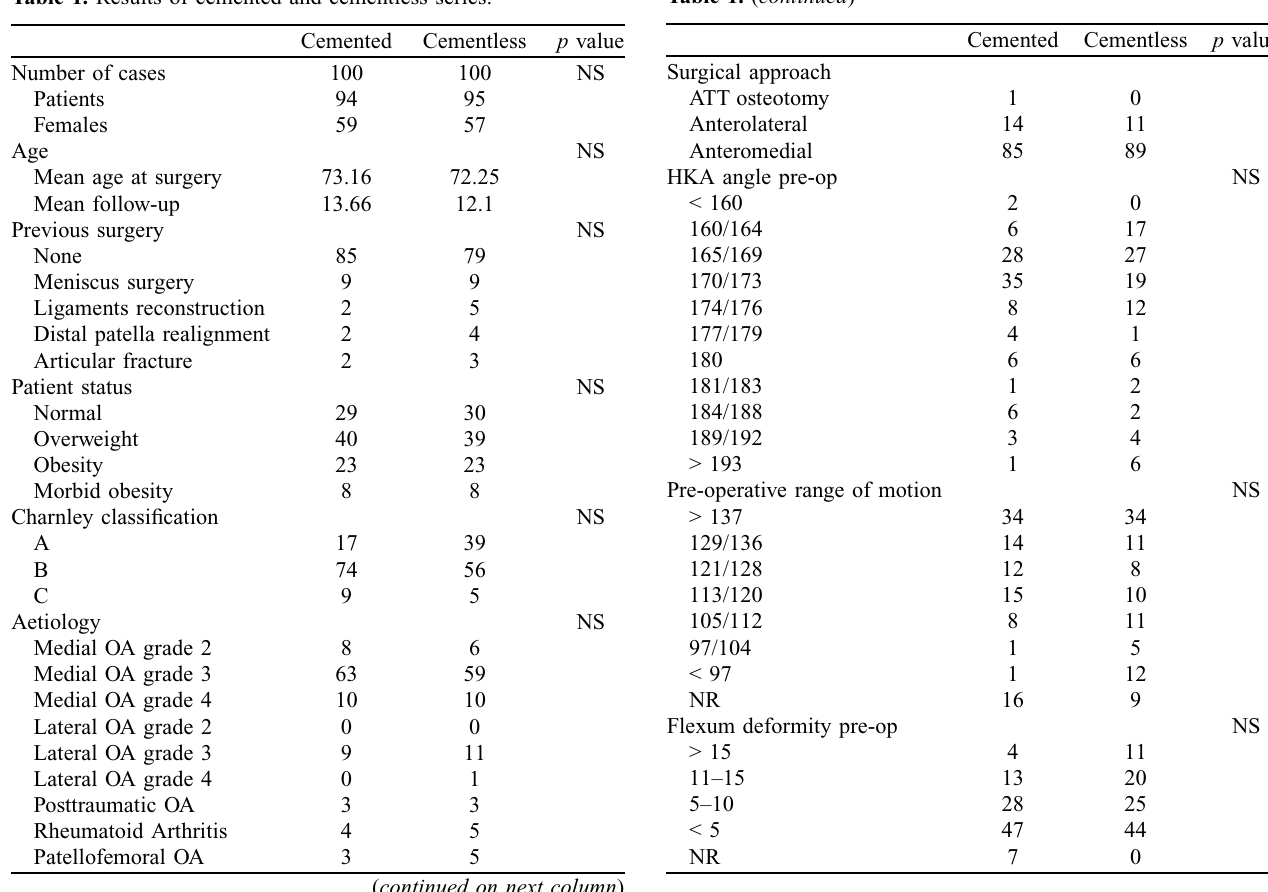
Table 1. Results of cemented and cementless